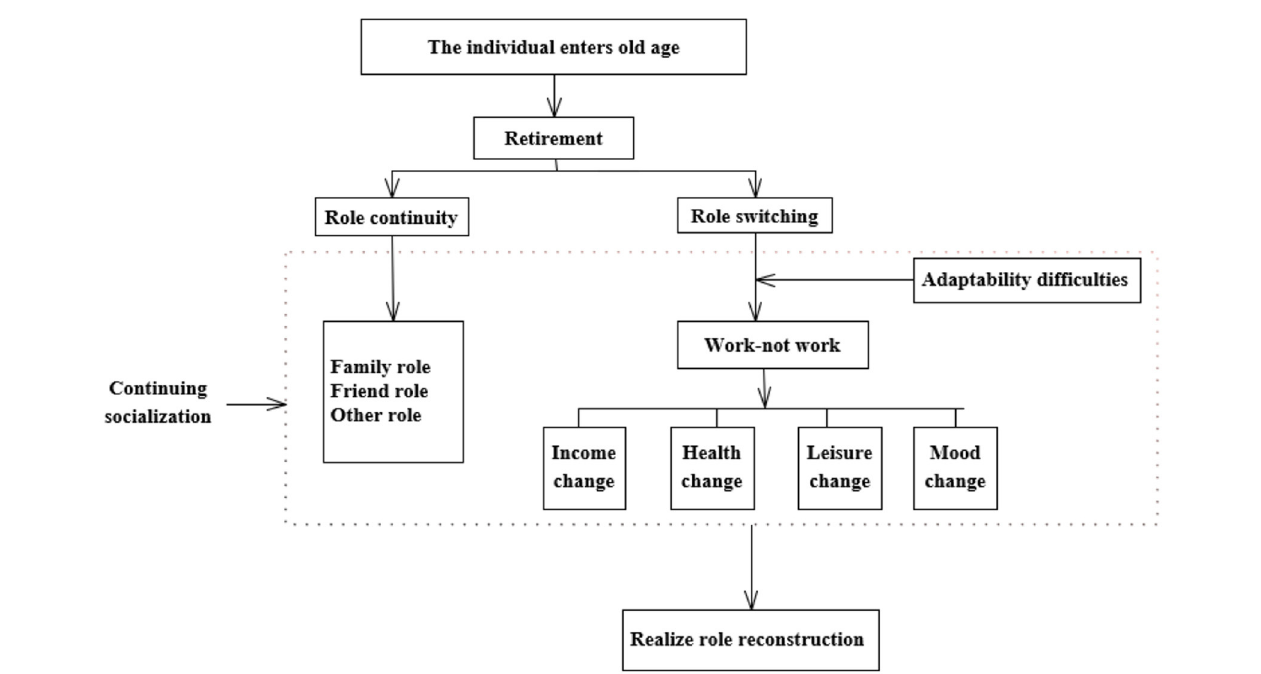
FIGURE 1 | The impact of